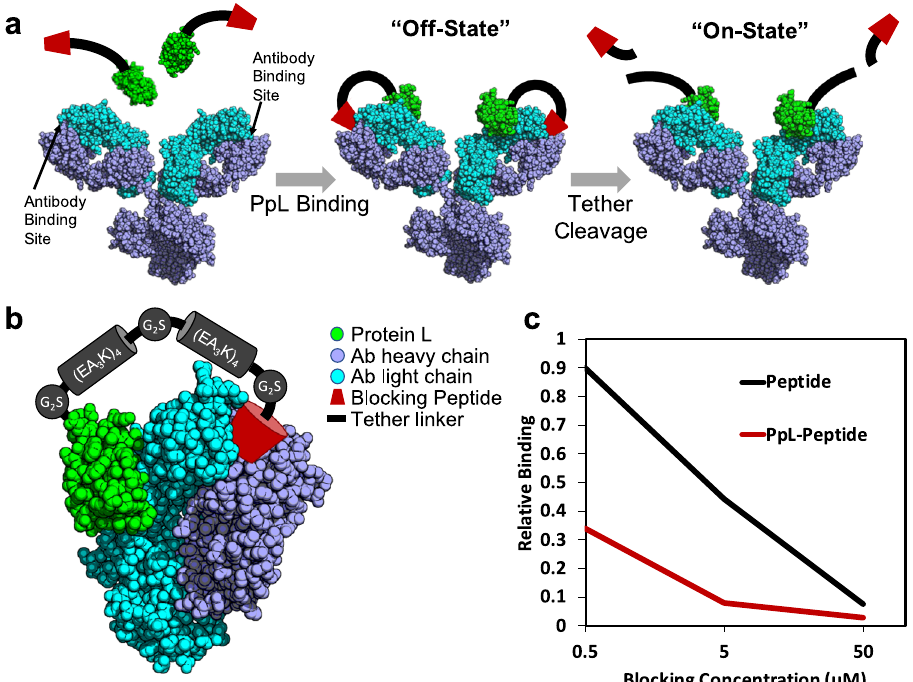
Fig. 1 Antibody inactivation through PpL based attachment of a tethered blocking peptide. a Schematic of the antibody blocking and activation strategy. b Rendering of the crystal structure (PDB 1MHH) 21 of PpL (green) bound to a Fab fragment of an IgG molecule. The path of a proposed linker is shown in cartoon form with the different segments labeled with their sequence. It is attached to the C-terminus of PpL (green) and reaches up and across the antigen binding pocket between the light (cyan) and heavy (blue) chains. In order to bend, the linker is broken into two alpha helical segments made to be approximately 3 nm each. c PpL linked to the fl ag epitope was shown to block an anti-FLAG antibody better than the fl ag epitope alone. Relative binding was estimated by ELISA and is expressed in relation to the anti-FLAG antibody alone. ( n = 1, graph for illustrative